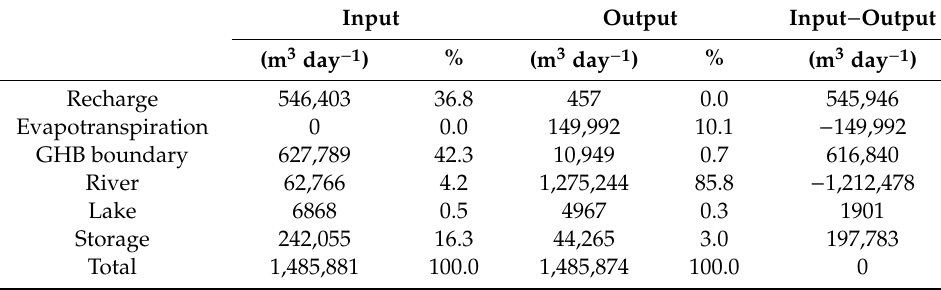
Table 2. Water balance at the end stress of the calibrated transient